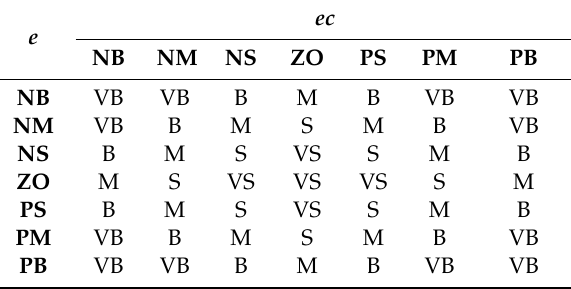
Table 5. Contraction–expansion factors a(e) and a(ec) fuzzy control